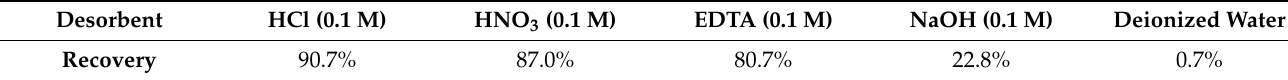
Table 6. Metal recovery of different